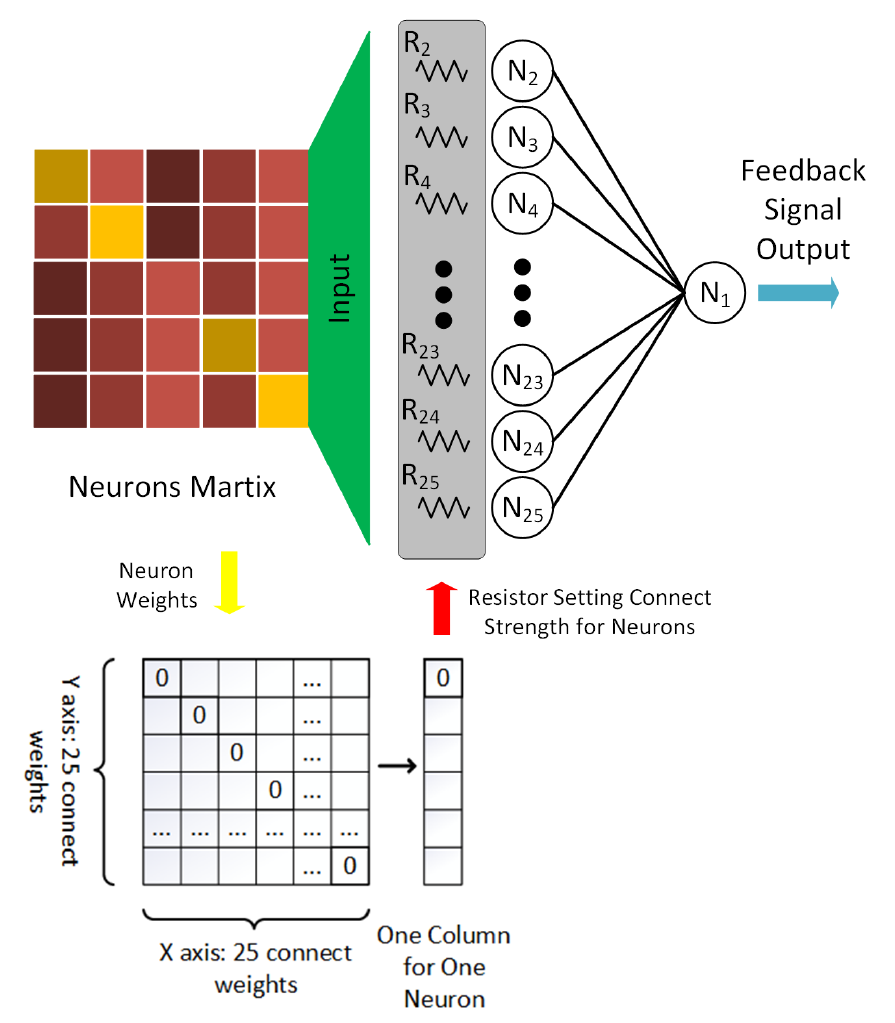
Figure 6. The Hopfield neural network of Neuron Matrix and